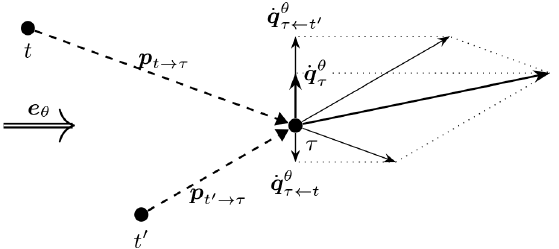
Figure 2. Illustration of how turbine-specific push-away pseudo- gradient vectors combine into a combined push-away pseudo- gradient vector.